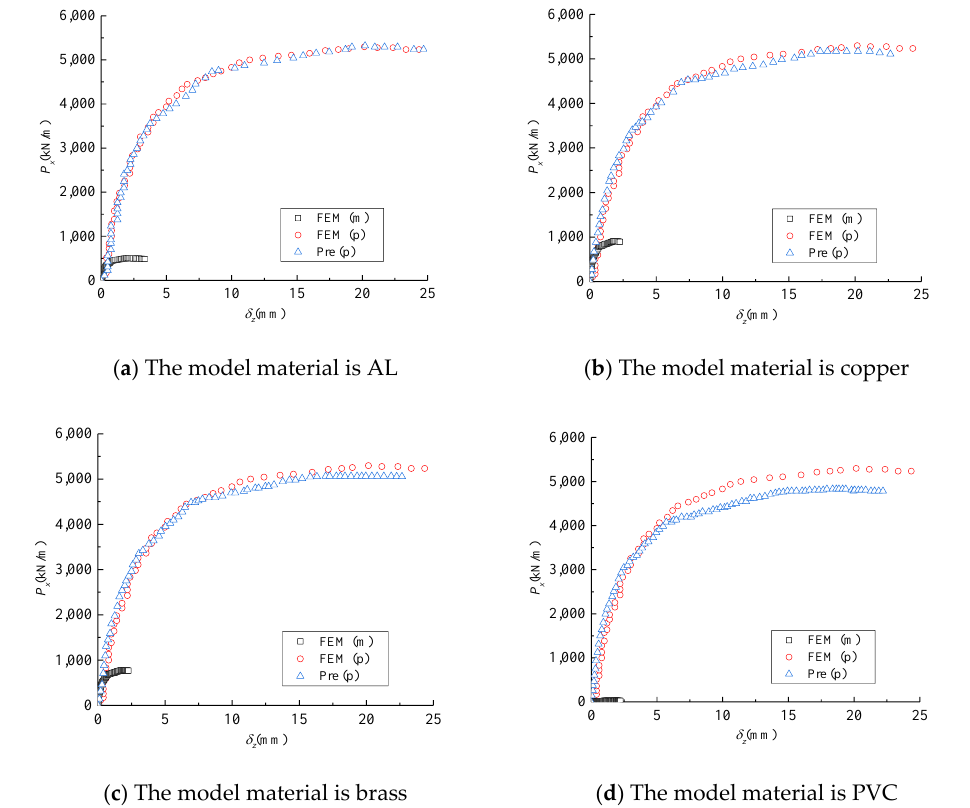
Figure 20. Comparison of partial similitude load-displacement curves for post-buckling of stiffened cylinders under axial compression when δ 0 = 0.3 ⎯ t.